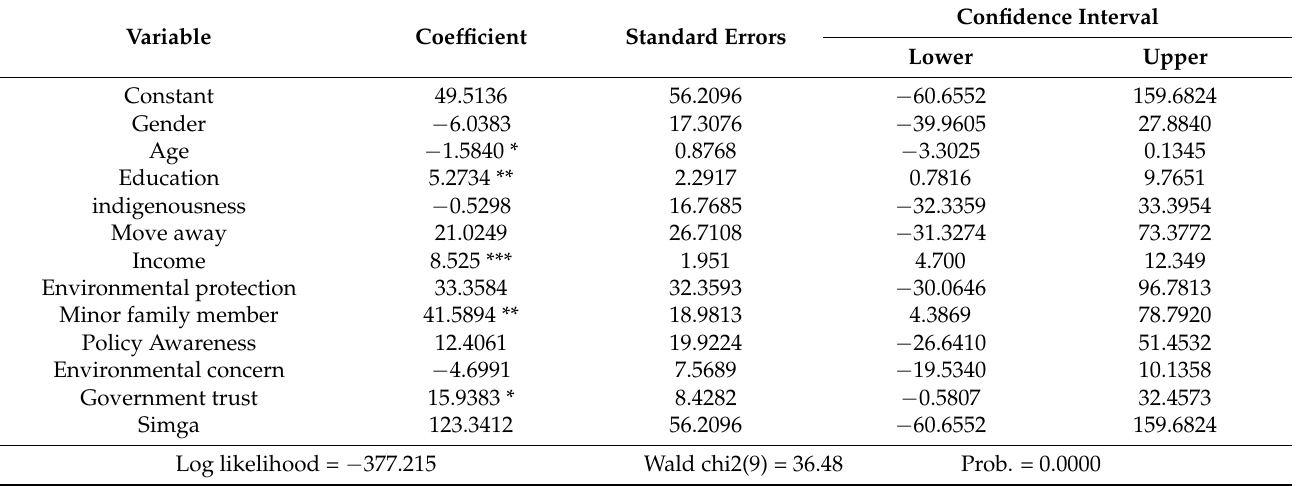
Table 5. Model estimation